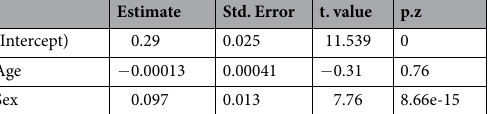
Table 2. Linear mixed model for all 756 samples across five TMAs. There is a strong correlation between patient sex and the percent of MYL4 positive